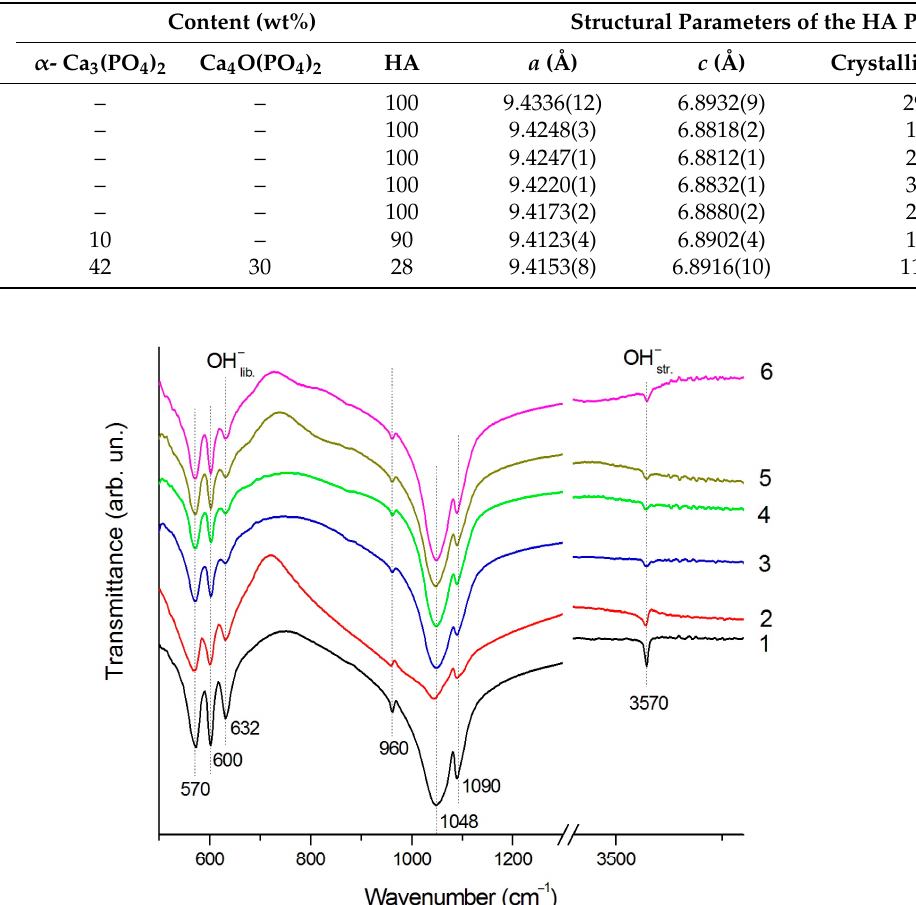
Table 2. Phase composition and structural parameters of the HA phase of the pellet sintered into the high-temperature furnace at different temperatures and at a humidity of 10%.